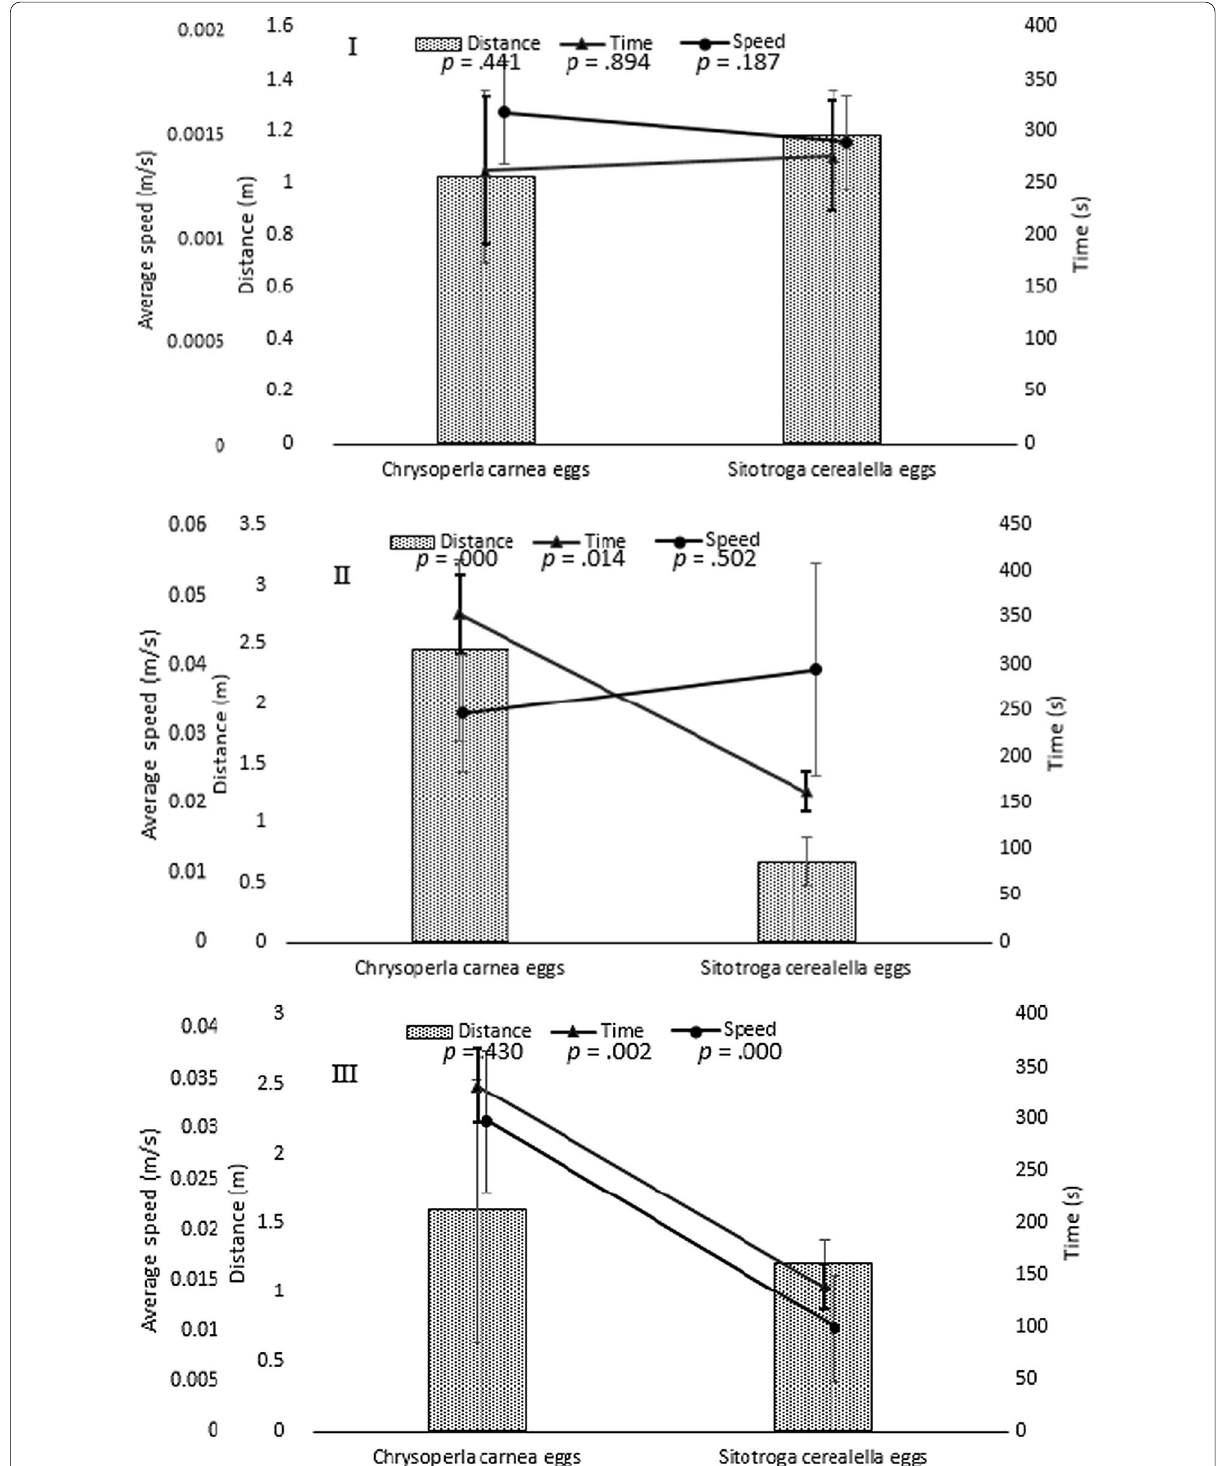
Fig. 7 Graph presents distance traveled (vertical bars) time (line with triangle ends) and speed (line with circular ends) of 1st ( I ), 2nd ( II ) and 3rd ( III ) instar C. carnea in movement area for ten minutes. All vertical lines indicate